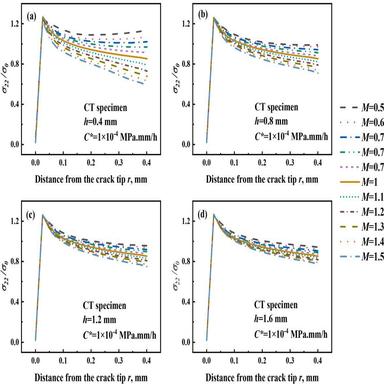
The radial variation of normalized opening stress ahead of the crack tip for CT specimens with M from 0.5 to 1.5 under weld width of (a) h = 0.4 mm, (b) h = 0.8 mm, (c) h = 1.2 mm and (d) h = 1.6 mm at C\ = 1 × 10− 4 MPa.mm/h.